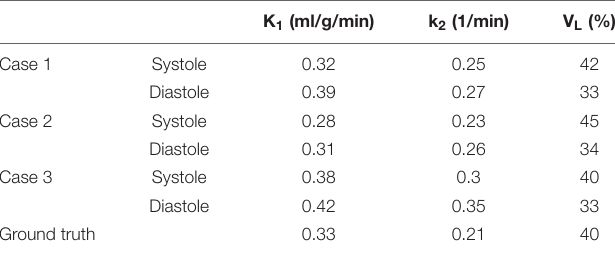
TABLE 3 | Quantitative indices estimated using 1TCM at systole and